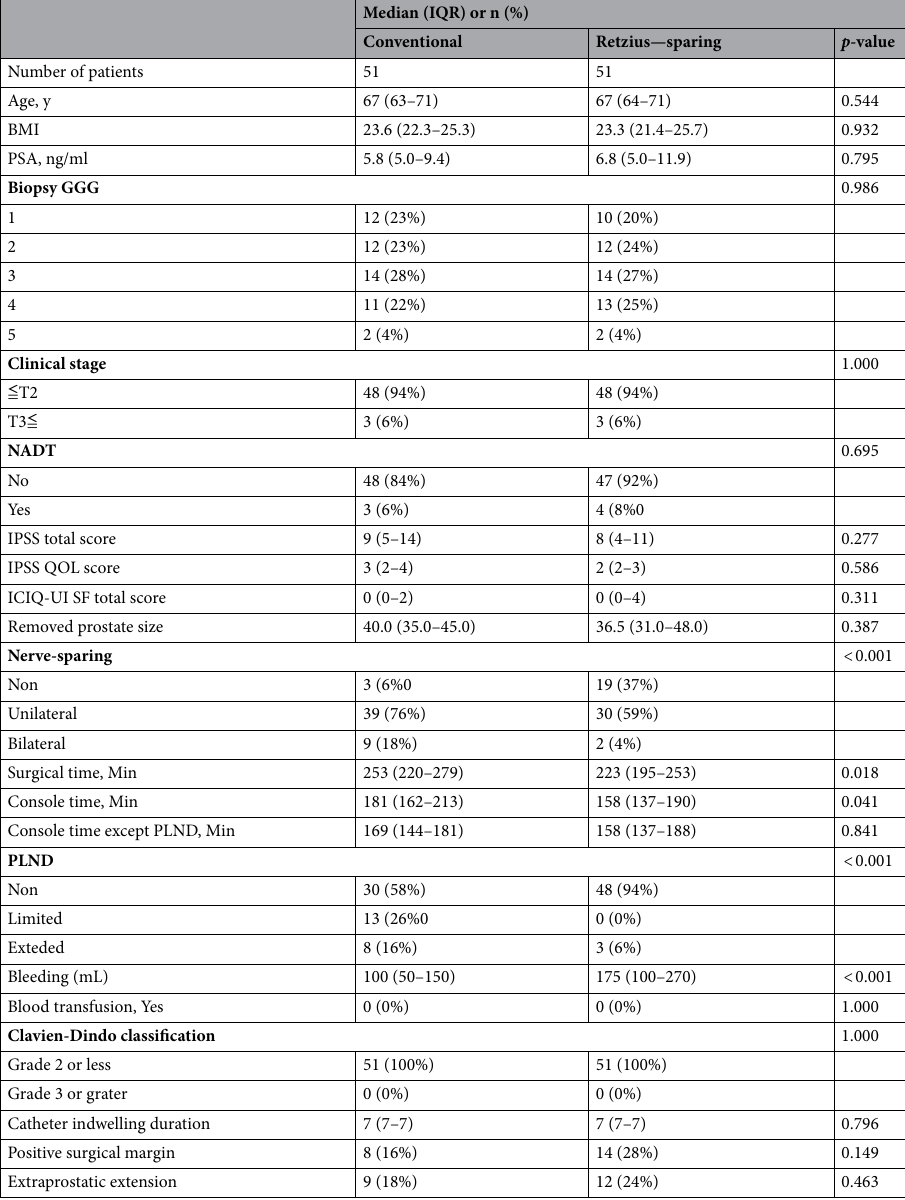
Table 1. Clinicopathological characteristics of propensity score matched conventional robot—assisted radical prostatectomy (RARP) and retzius—sparing RARP groups in 51 patients each. BMI, body mass index; GGG, Gleason grade group; IQR, interquartile range; NADT, neoadjuvant androgen deprivation therapy; PLND, pelvic lymphnode dissection; QOL, quality of life; ICIQ-UI SF, International consultation on incontinence questionnaire-urinary incontinence short